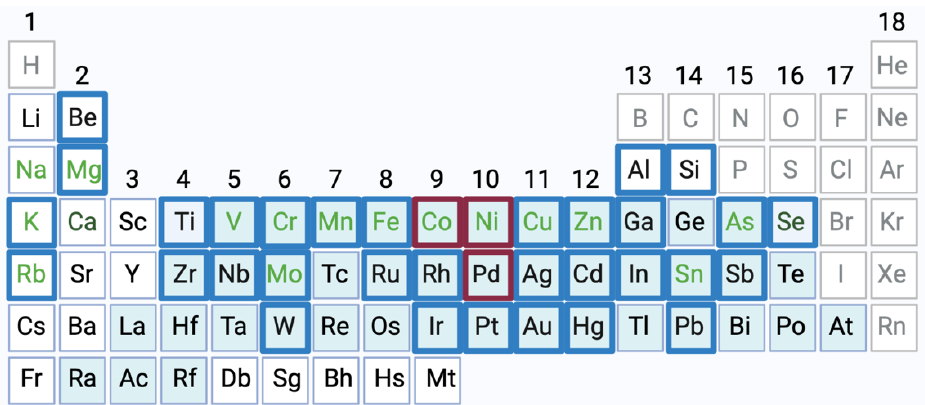
Figure 1. Metals implicated in allergic reactions. Metallic elements related to allergic reactions are highlighted in this periodic table of the elements (blue boxes, without lanthanides and actinides). Most of the metal allergens belong to the group of heavy metals (blue background) and some are (likely) essential trace elements (light green letters) [6,10]. Non-metallic elements are depicted in grey letters. This review focuses on general adverse and immunotoxic effects of nickel (Ni, Ni 2+ ions), cobalt (Co, Co 2+ ions) and palladium (Pd, Pd 2+ ions) (highlighted in red) [6]. Created with BioRen- der.com.